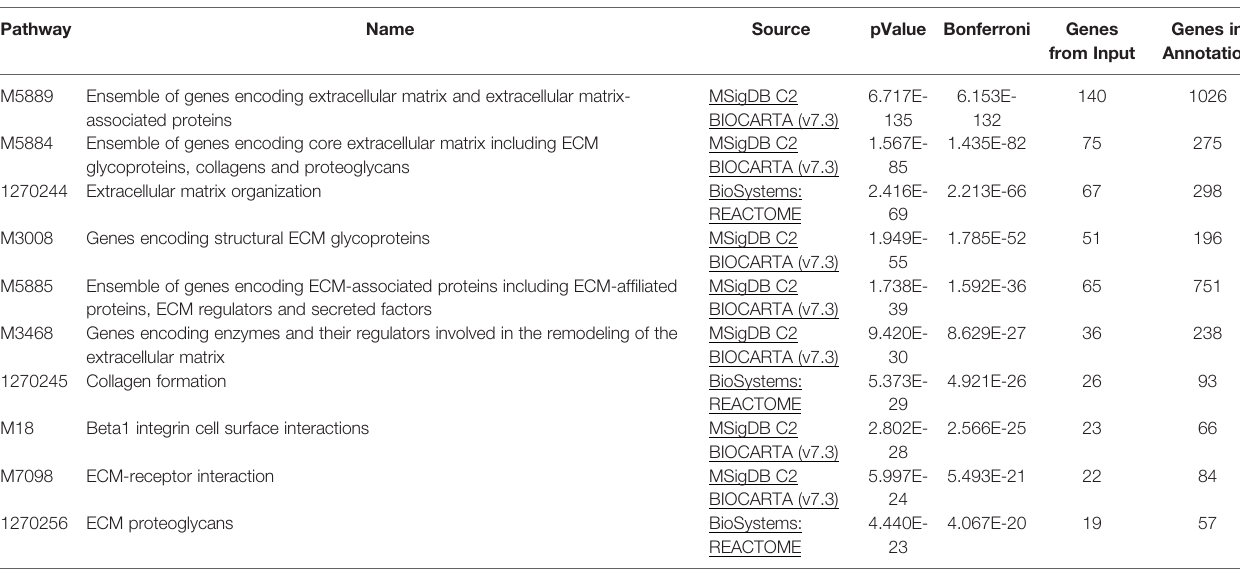
TABLE 3 | Most enriched